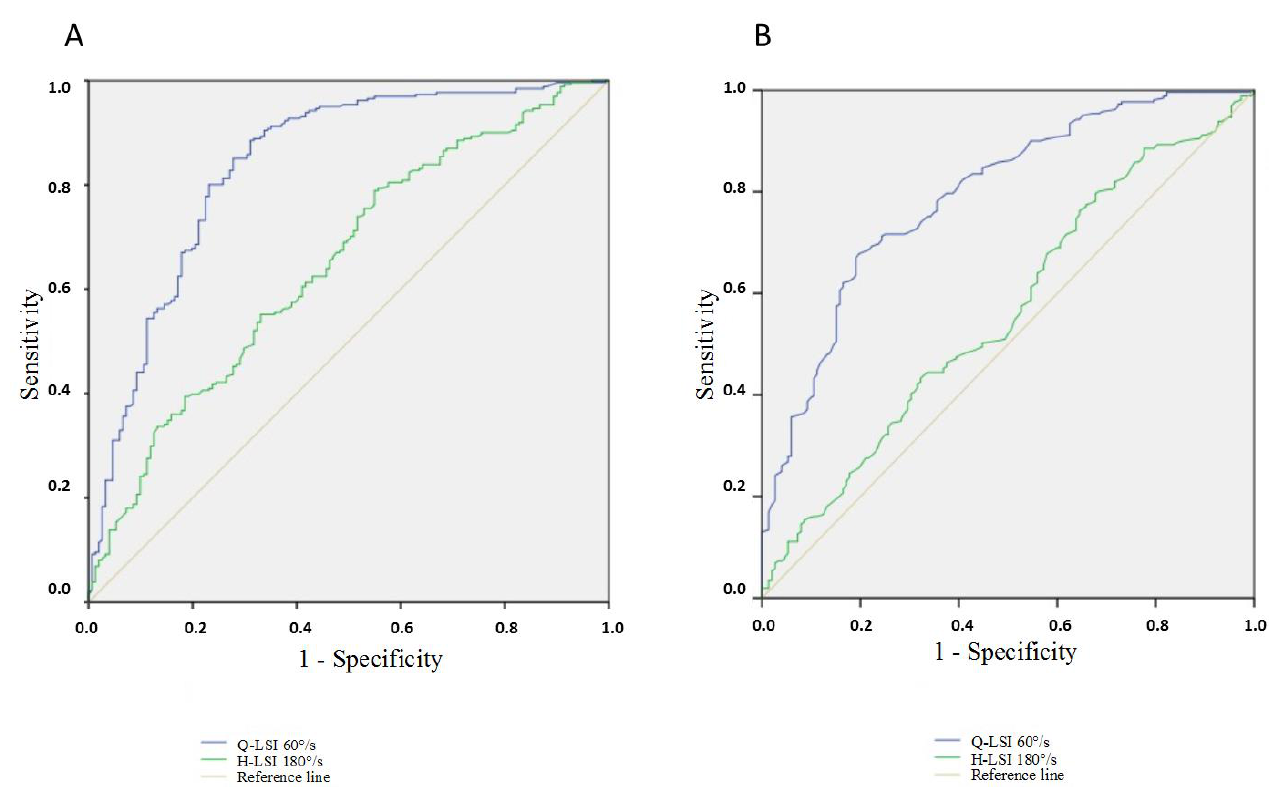
Figure 2. ( A ) ROC curve of Q-LSI at 60°/s and H-LSI at 180°/s; ( B ) ROC curve of QS/BW (operated limb) and QS/BW at 60°/s (contralateral limb). Q-LSI: Quadriceps Limb Symmetry Index; H-LSI: Hamstring Limb Symmetry Index . QS/BW: Quadriceps Strength peak torque to Body Weight.